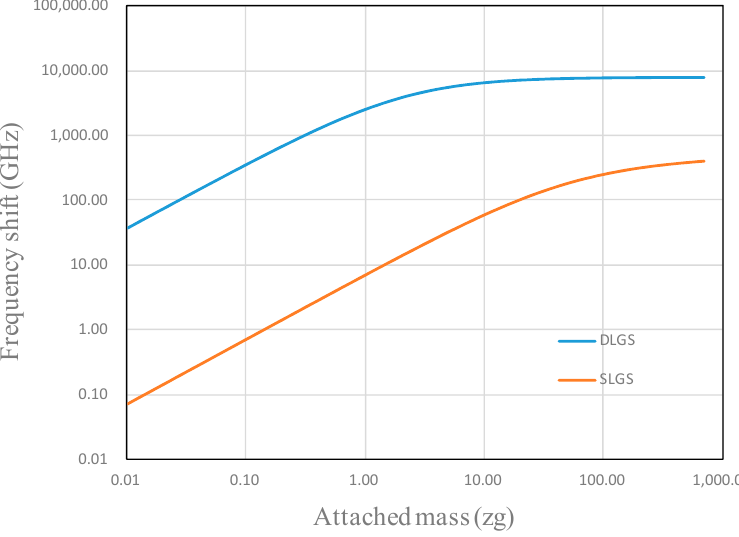
Figure 5. Comparison of the frequency shift between DLGSs and SLGSs with attached nanoparticle for the temperature difference of Δ T = 100 K ( e 0 a = 0 nm, ξ = η = 0.5).